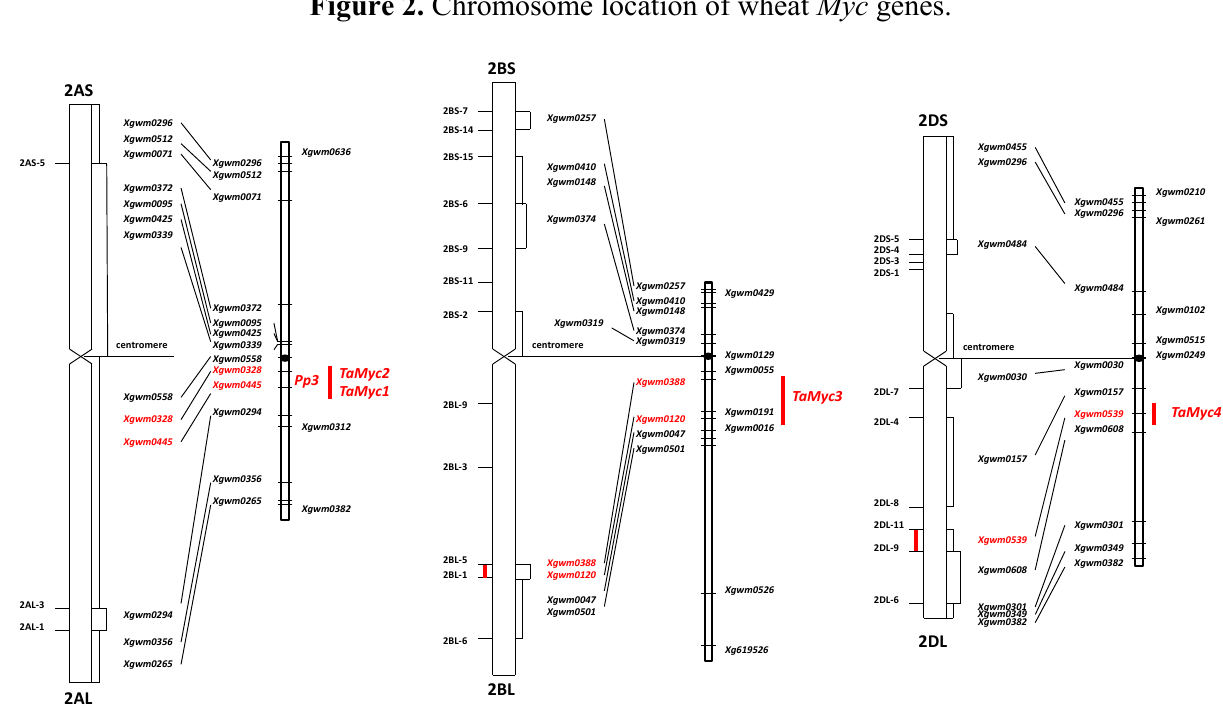
Figure 2. Chromosome location of wheat Myc